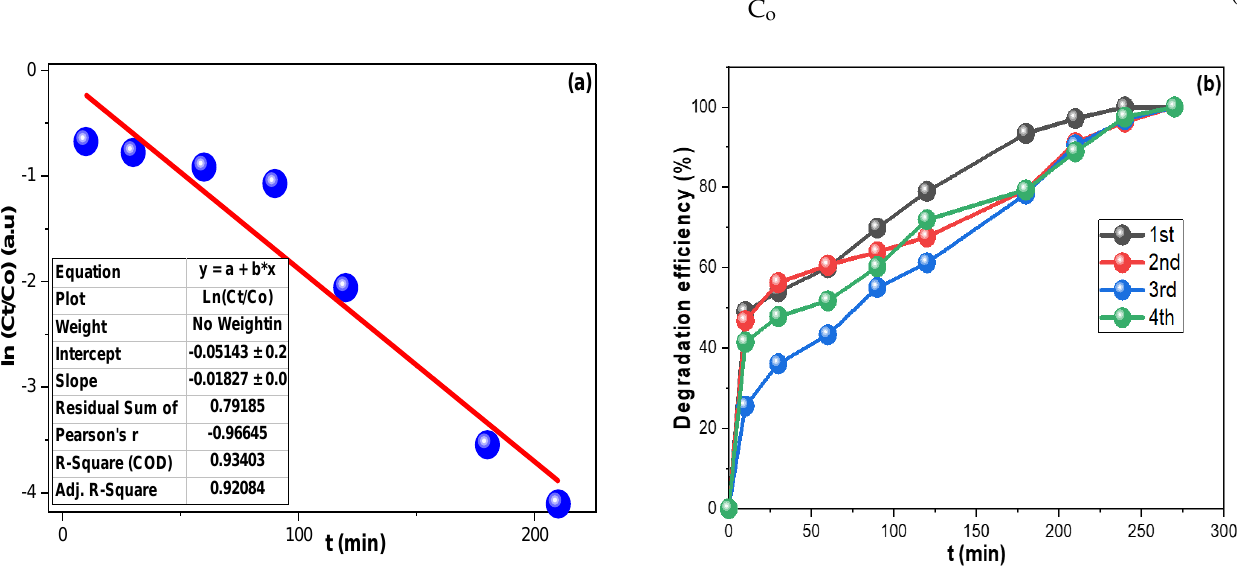
Figure 9. ( a ) The first-order kinetic investigation and ( b ) reuse study for BiOI in degrading IC in water under artificial visible light.